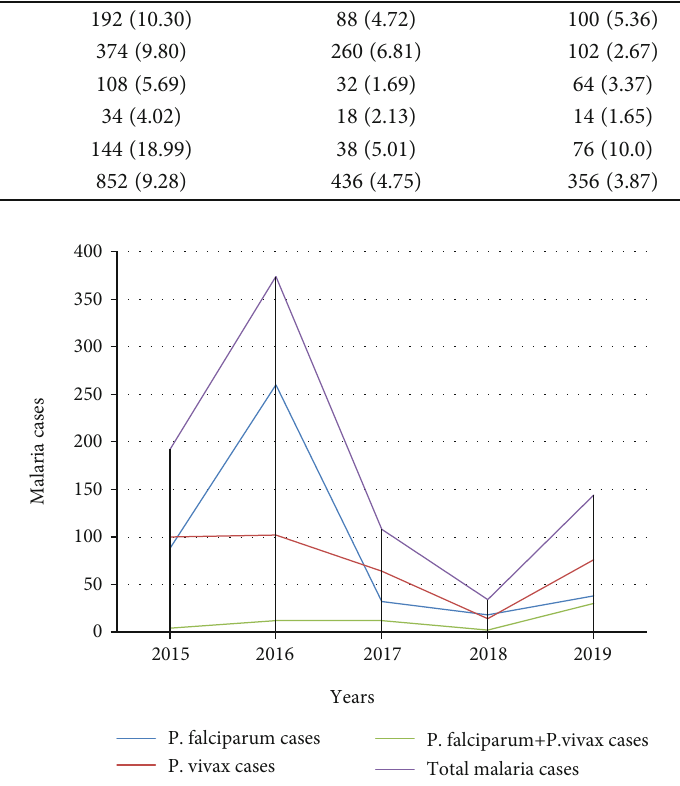
Figure 1: Species trend of malaria at Bichena Primary Hospital from 2015 to